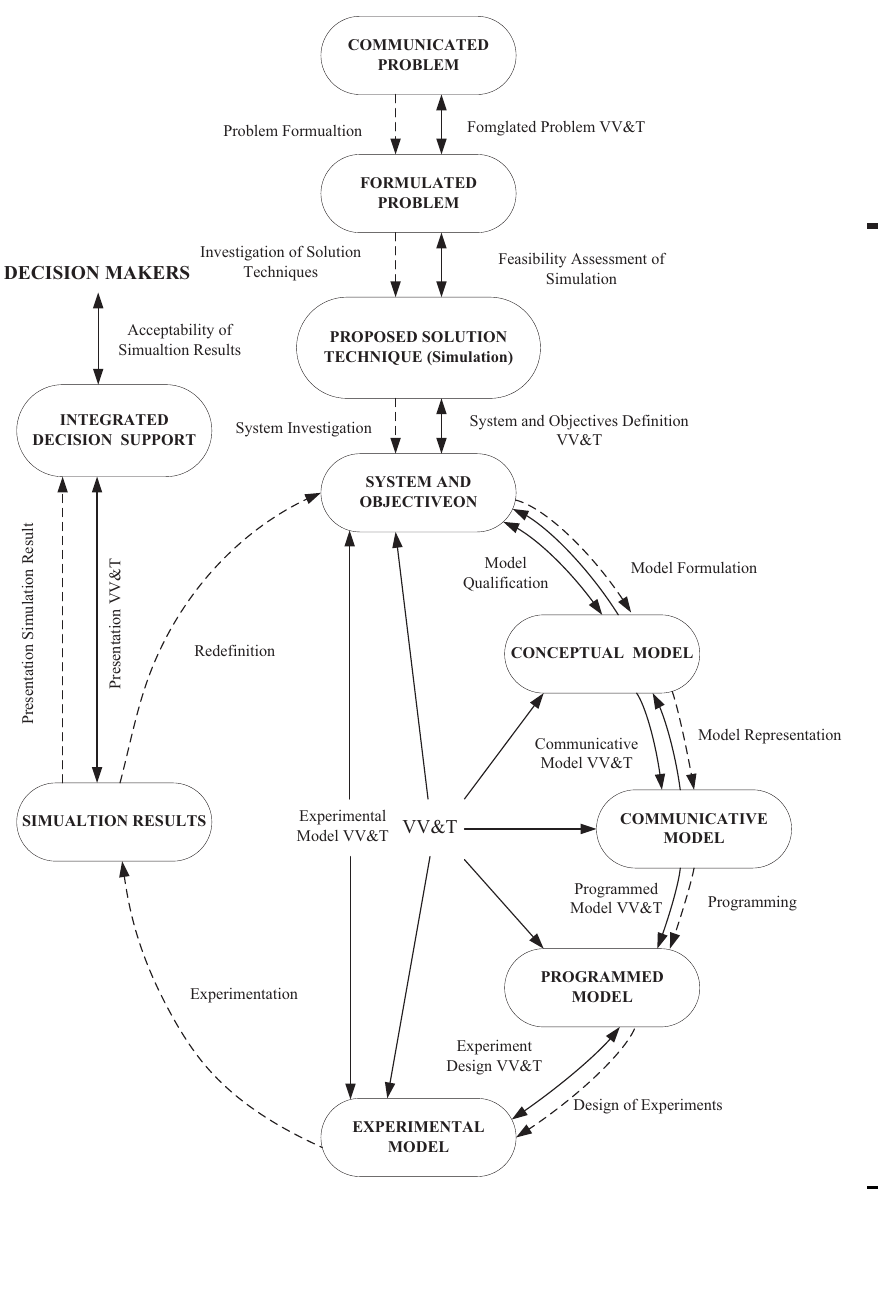
Figure 4. The life cycle